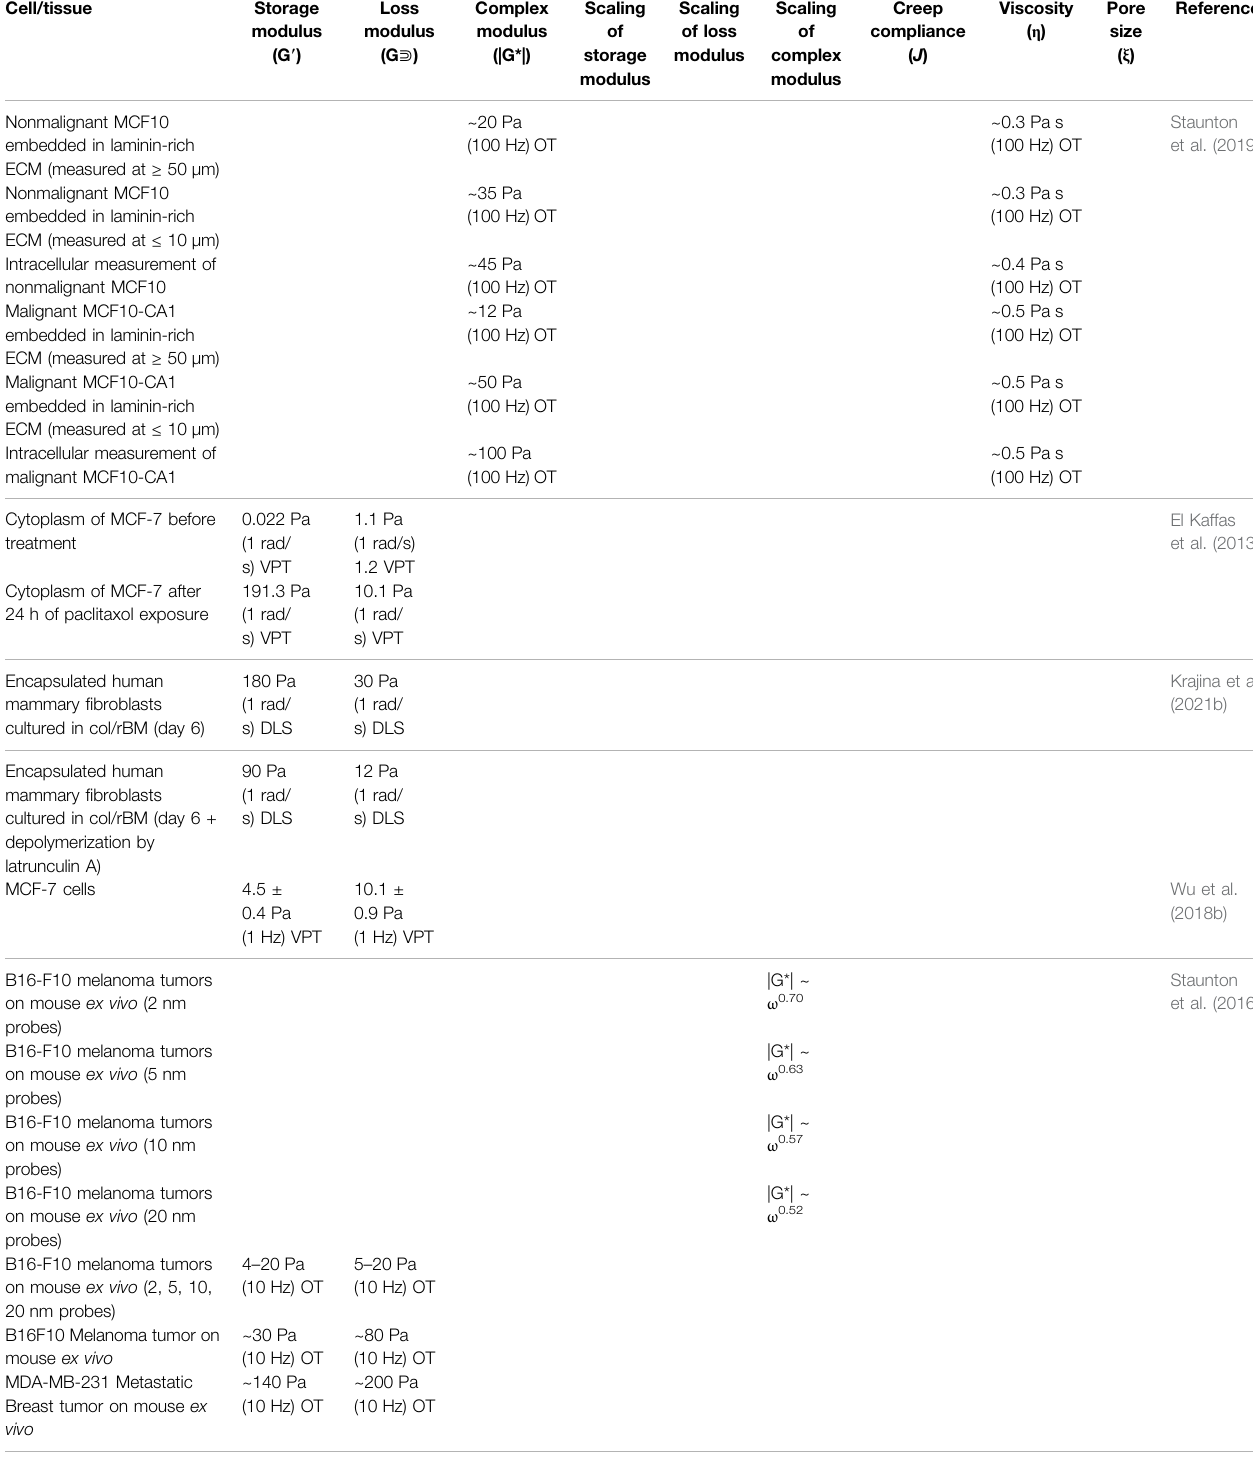
TABLE 6 | Microrheological properties of mammalian cells and tissue of the integumentary system measured by various microrheological techniques.